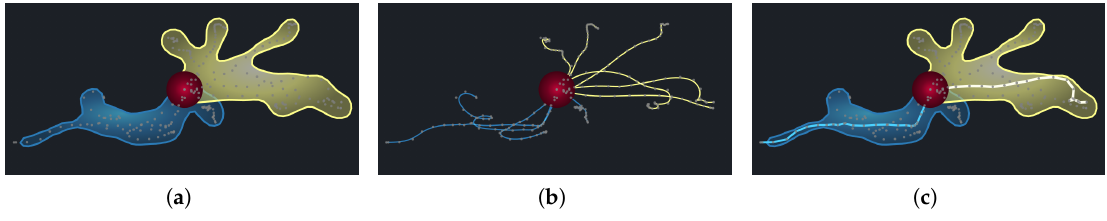
Figure 8. Alternative designs: ( a ) displaying the track points of all timestamps inside the contour; ( b ) displaying both the track points and the central pathlines; and ( c ) combining track points, central pathlines, and outer